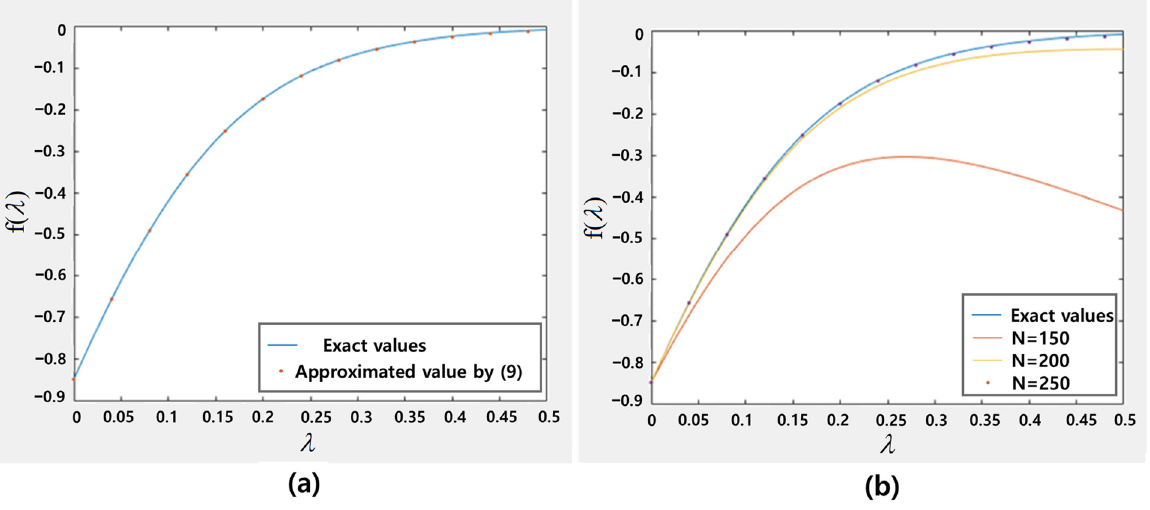
Figure 7. The estimated kernel functions using the data in Table 3.